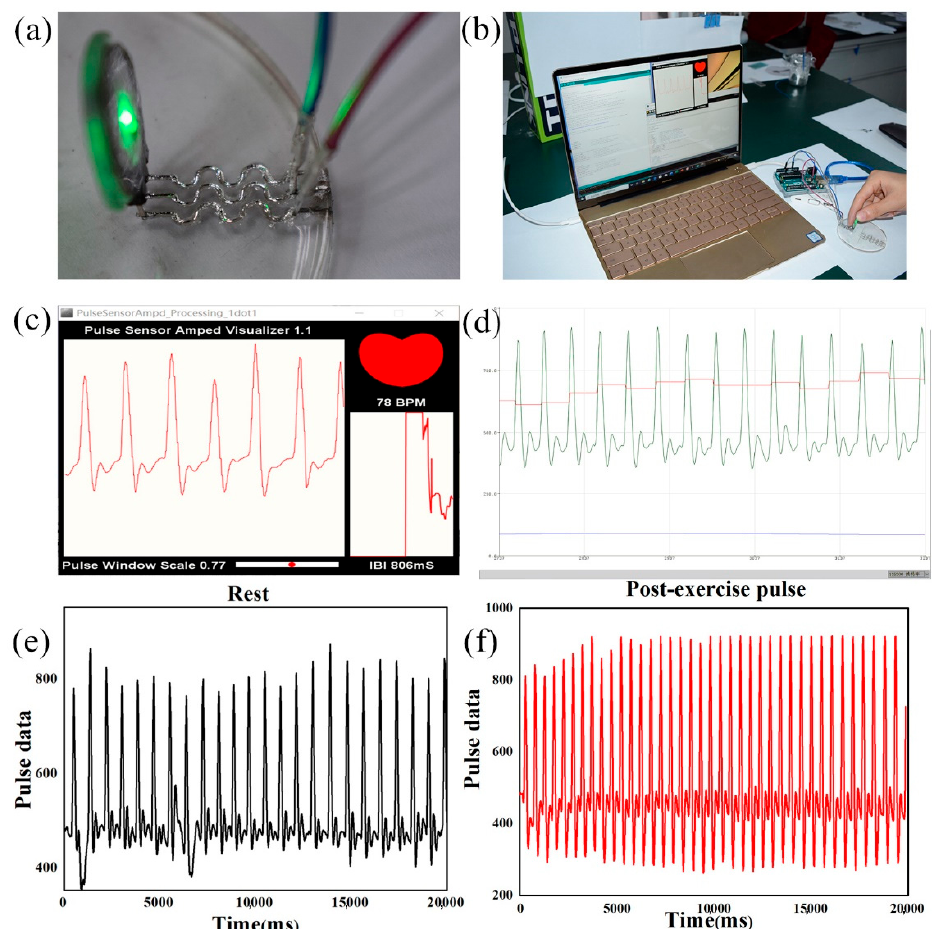
Figure 5. ( a ) Sensor working in LM circuits. ( b ) Flexible sensor circuit working system. ( c ) Sensor image on an Arduino sketch. ( d ) Display of sensor image on an Arduino sketch. ( e ) Pulse sensor image at rest. ( f ) Post-exercise pulse sensor image.